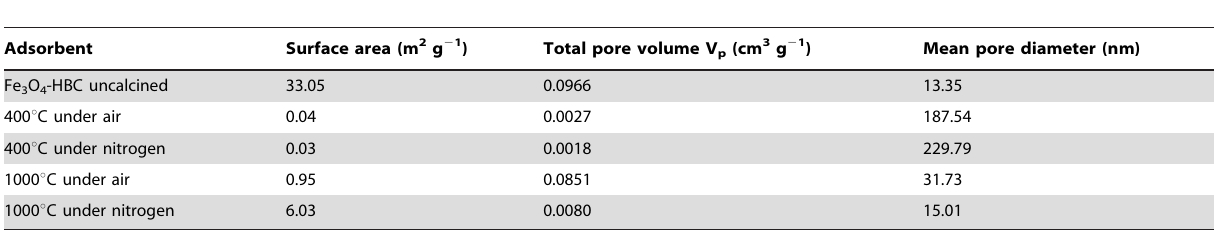
Table 1. Textural characteristics of uncalcined and calcined Fe 3 O 4 -HBC composites.